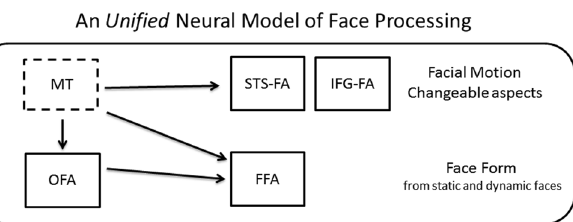
Figure 2. The unified neural model of face processing. The dorsal face areas are engaged in the processing of facial motion and changeable facial aspects, whereas the ventral areas are engaged in the processing of facial form. Area MT sends input to the dorsal areas for motion processing, and to the ventral areas for structure- from-motion analysis.